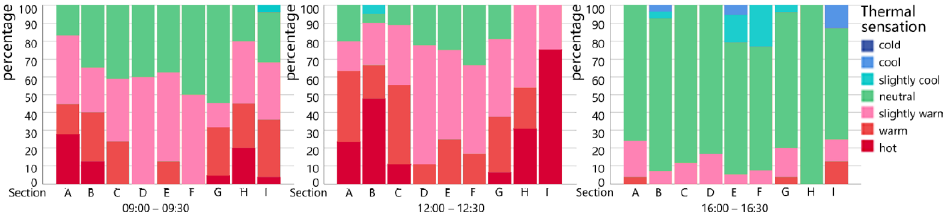
Figure A9. Thermal sensation votes of the three time periods on 11 September.